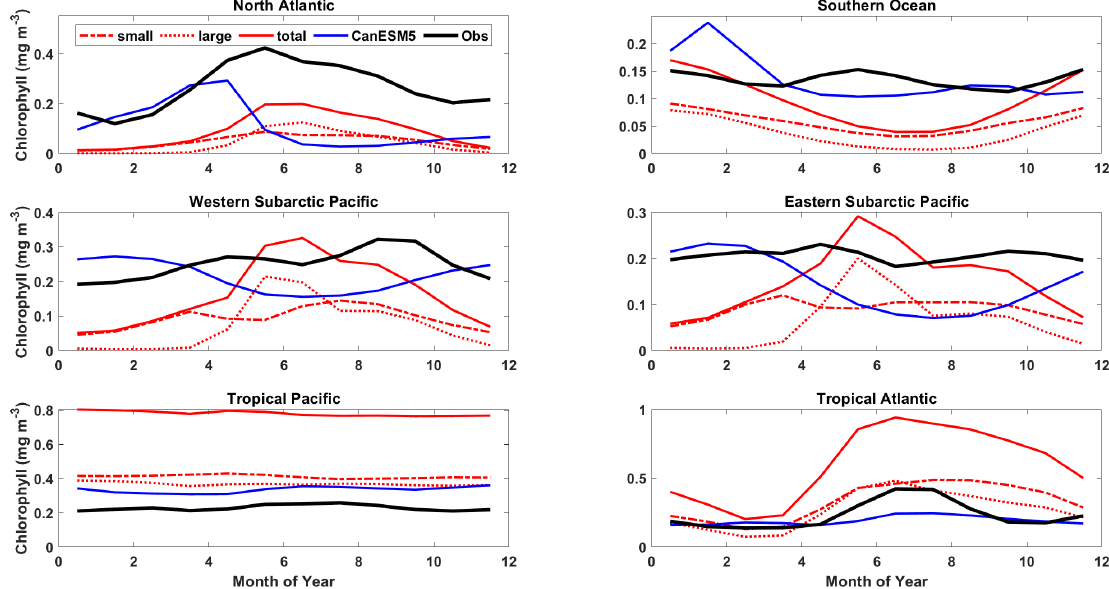
Figure 17. Mean annual cycle of surface chlorophyll for the representative ocean regions shown in Figs. 14 and 16. CanESM5-CanOE large and small phytoplankton concentrations are shown separately and combined (red) along with CanESM5 (blue) and observational estimates (black). Region definitions are shown in Table S5 and Fig. S5.